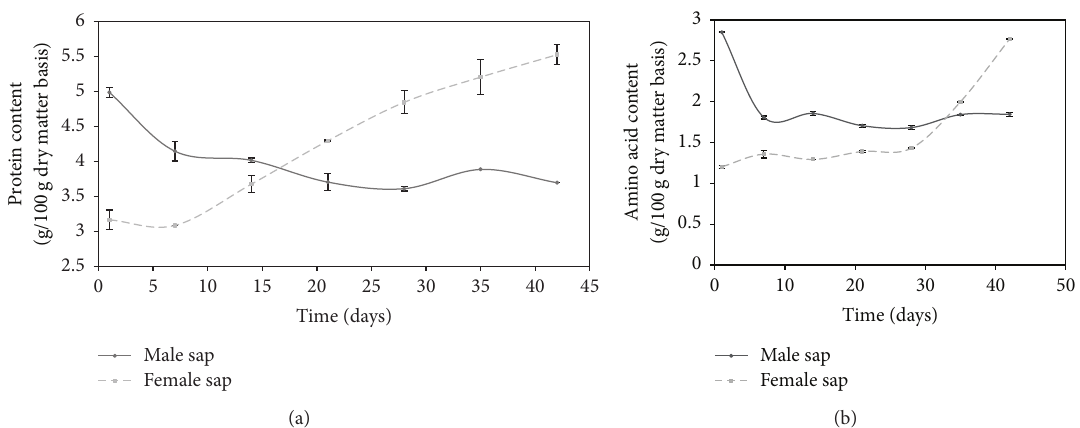
Figure 2: Variation of protein and amino acid contents of male and female date palm sap according to the collection time. (a) Variation of protein content of male and female date palm sap according to the collection time. (b) Variation of amino acid content of male and female date palm sap according to the collection time.